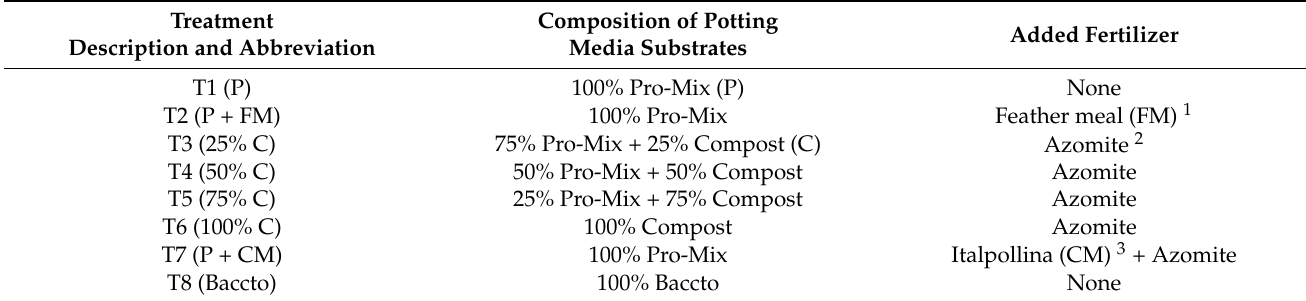
Table 1. Composition of potting media substrates and fertilizer used for each treatment. Treatment Description and